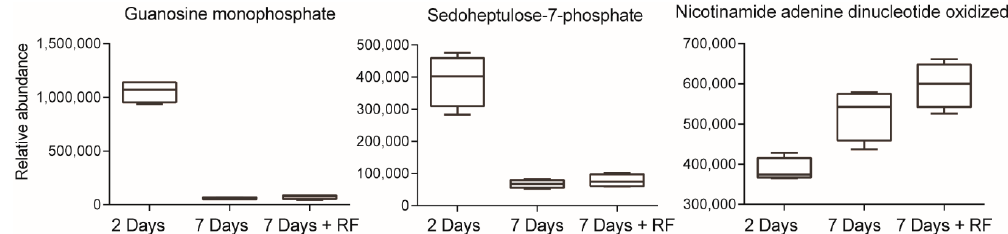
Figure 2. Multi-group analysis showing changes of the metabolome in MCF-7 cells treated with the vehicle (control). Cells were analyzed at two days, seven days and seven days with refeeding ( n = 4/group). Box plots show relative abundances of guanosine monophosphate, sedoheptulose-7-phosphate and oxidized nicotinamide adenine dinucleotide oxidized changing over time. The results indicated that two days after a simultaneous dose of both drugs (palbociclib and fulvestrant) metabolites were dysregulated in multiple metabolic pathways in central carbon metabolism: The tricarboxylic acid (TCA) cycle, PPP, and purine synthesis. Figure 3 illustrates the changes to these pathways on single and combination dosing. In the TCA cycle, succinate was